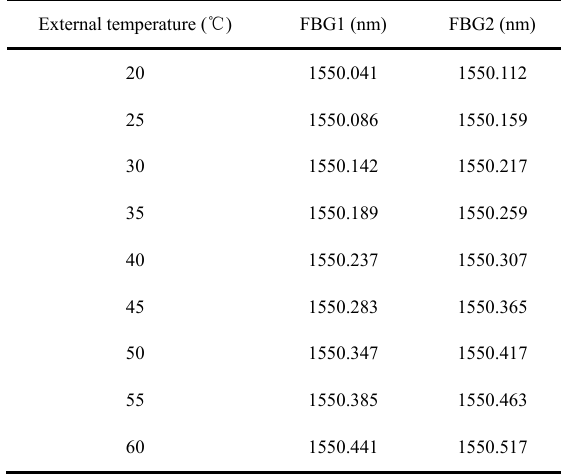
Table 3 Temperature calibration experimental data of FBG1 and